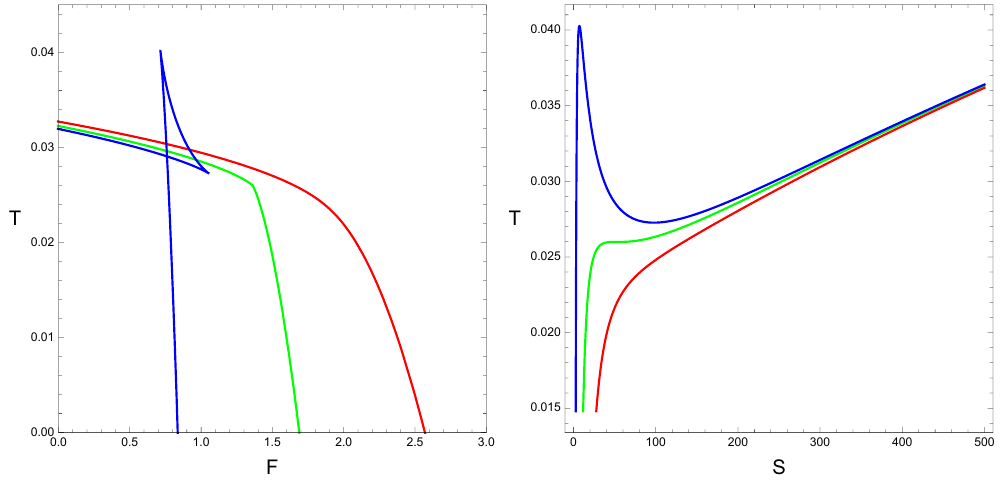
Figure 1 . Phase transition of a bulk black hole. On the left, the behavior of the temperature T against the free energy F of a charged black hole in d = 4 is shown. On the right is the behavior of T against the entropy S . In each case we have plotted the critical isocharges (green), and isocharges at Q > Q crit (red) and Q < Q crit (blue). Below criticality we see the swallowtail behavior of F , characteristic of a (cid:12)rst order phase transition, and the oscillatory behaviour of T ; at criticality the swallowtail becomes a cusp in the T (cid:0) F plane, and an in(cid:13)ection point in the T (cid:0) S plane| the phase transition is here of second order. The AdS radius l has been set to 10 for which the critical charge is Q c = 10 = 6. The values of Q on these isocharges are Q = 0 : 5 Q crit (blue), Q = Q crit (green) and Q = 1 : 5 Q crit